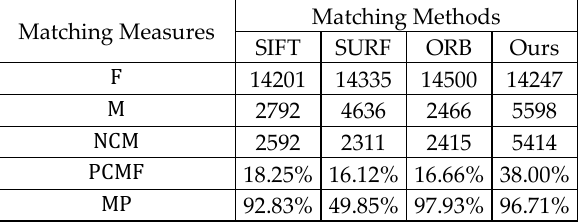
Table 4. Matching measures for the third image pair when using SIFT, SURF, ORB and our proposed method.